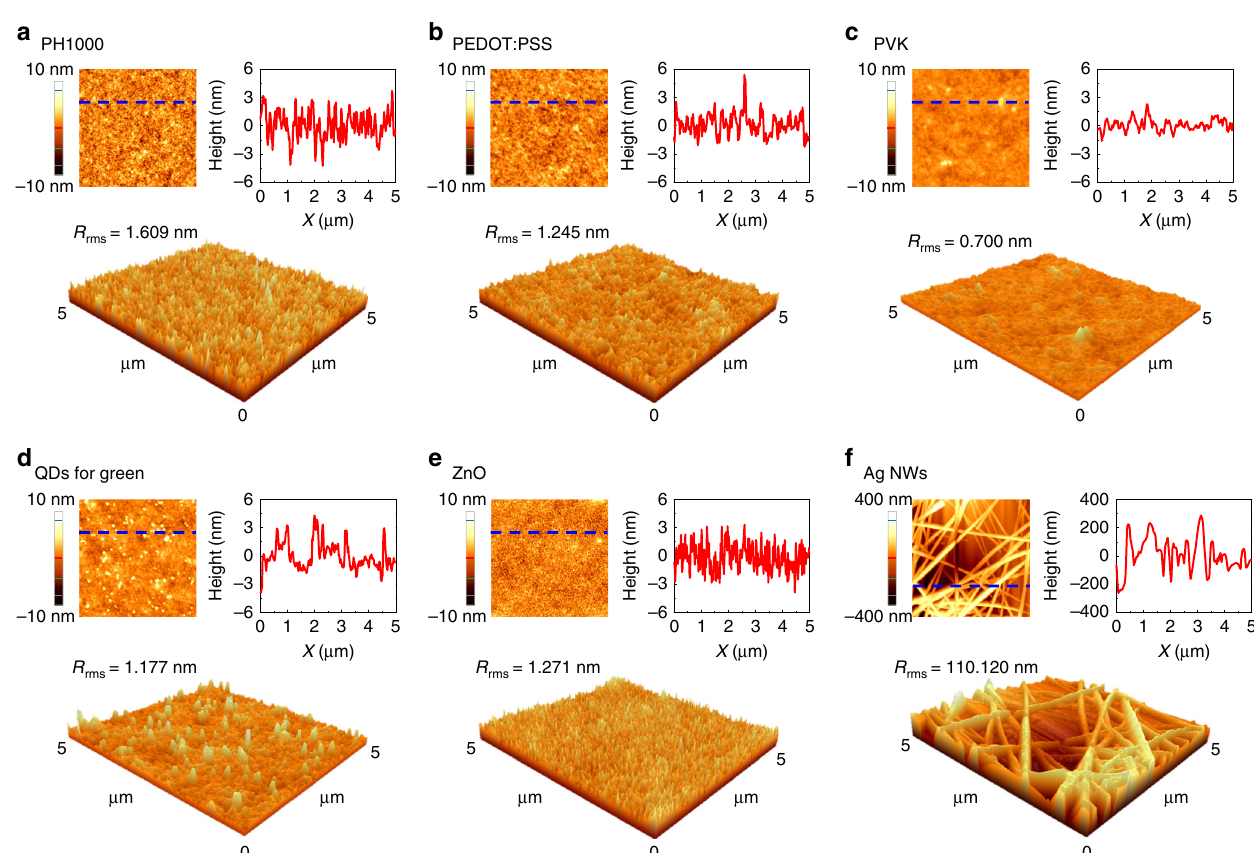
Fig. 4 Surface morphology of each layer formed by pen drawing. Atomic force microscopy (AFM) topographic images, height section analyses, and three- dimensional images of PH1000 ( a ), PEDOT:PSS ( b ), PVK ( c ), QDs for G ( d ), ZnO ( e ), and Ag NWs ( f )